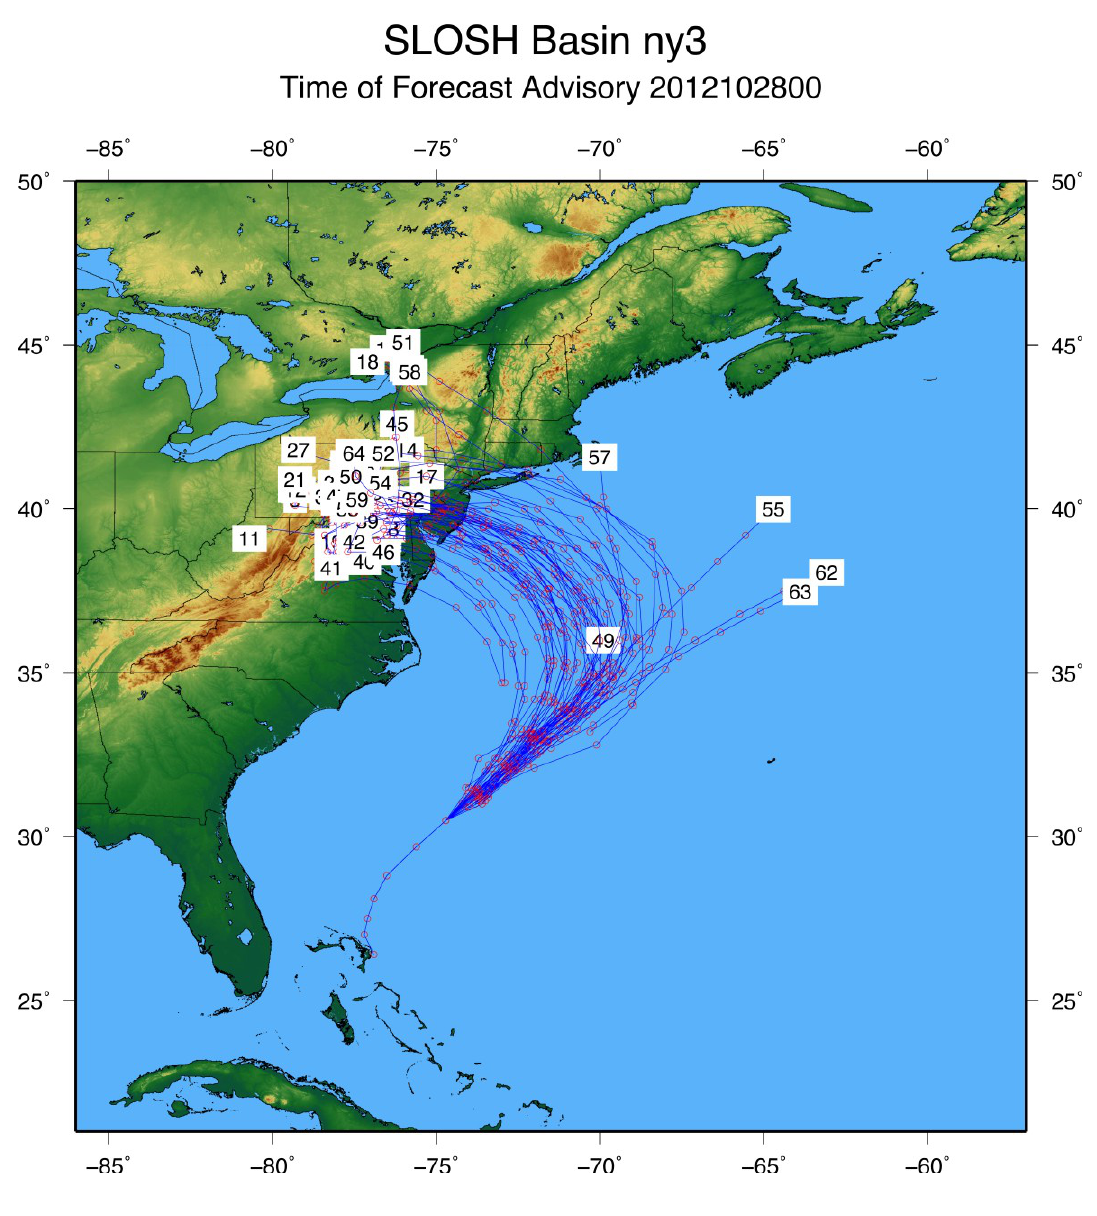
Figure 5. Example of the model tracks used by the Hurricane Specialists at NHC to develop the OFCL forecast track for Hurricane Sandy. It depicts the large spread in the model tracks with various wind intensities, sizes and track locations. This meteorological guidance is used as forcing to run the SLOSH ensemble storm surge simulations. The label inside the white box at the end of each track indicates the ensemble member number that corresponds to the number in the horizontal axis in Figure